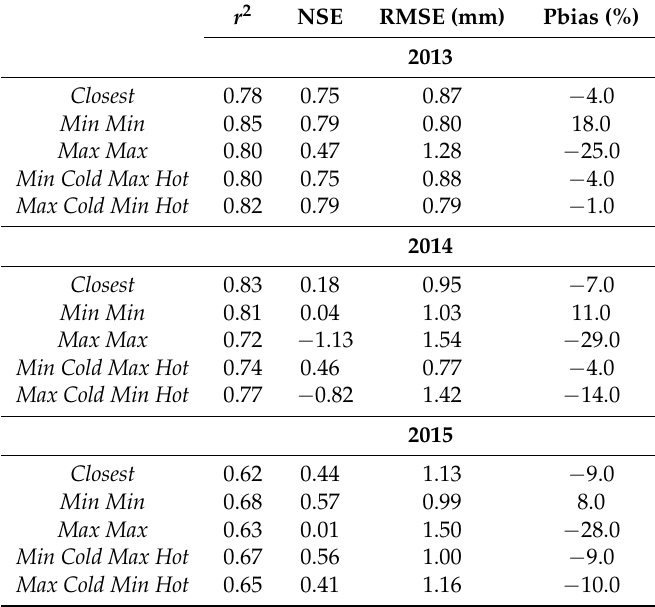
Table 3. Model evaluation results comparing 24-h ET estimates computed using five different calibration schemes with measured ET at the AmeriFlux eddy covariance (EC) station. (NSE: Nash–Sutcliffe Efficiency, RMSE: Root Mean Squared Error). r 2 NSE RMSE (mm) Pbias